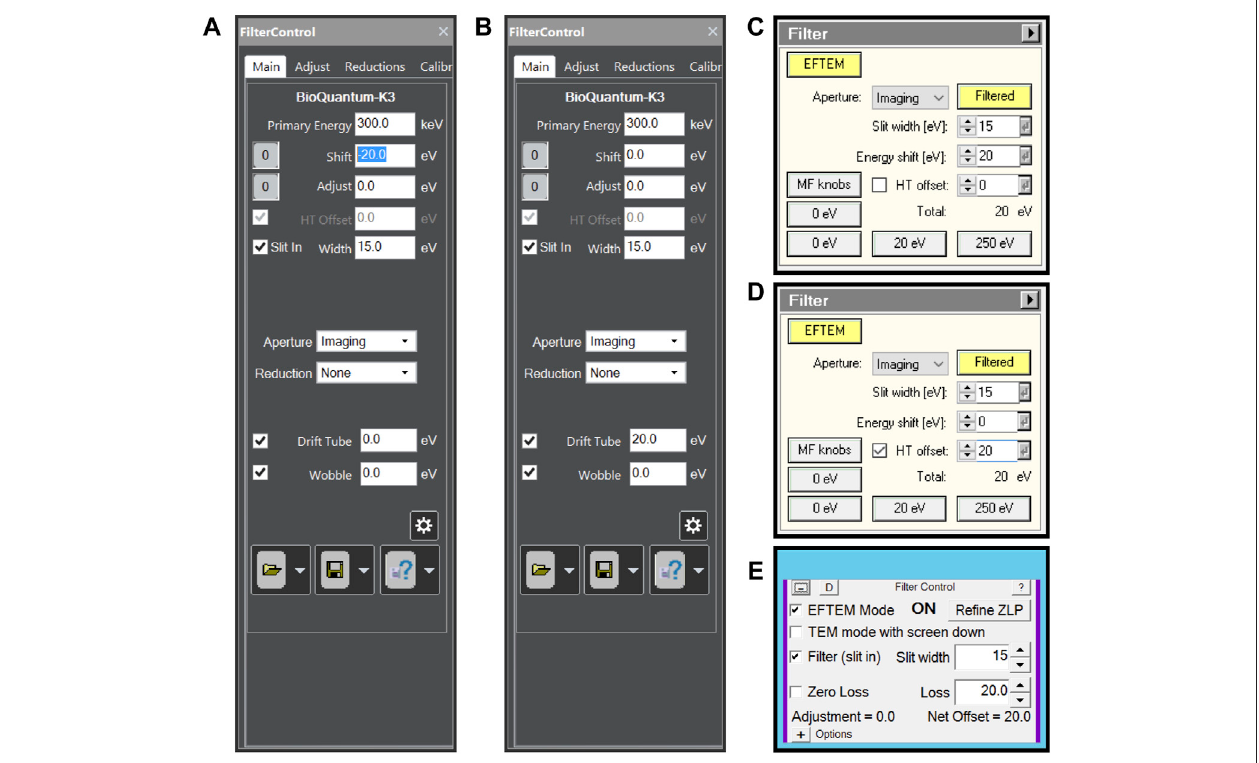
FIGURE 1 | Energy fi lter settings for plasmon imaging when (A) using a Gatan energy fi lter controlled by Digital Micrograph software and using energy shift, (B) using a Gatan energy fi lter controlled by Digital Micrograph software and using Drift tube offset, (C) using a Thermo Scienti fi c Selectris(X) energy fi lter using energy shift, (D) using a Thermo Scienti fi c Selectris(X) energy fi lter using high tension offset and (E) using any energy fi lter through